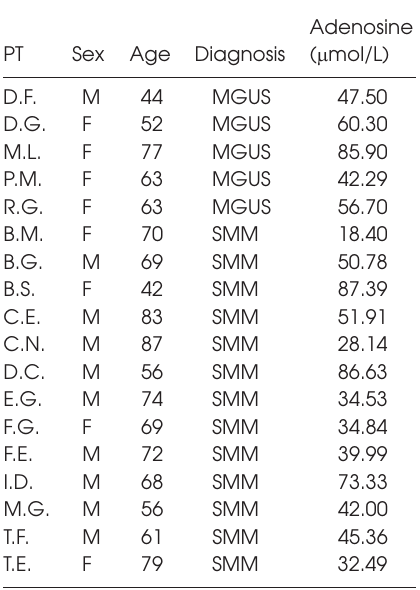
table 2. Characteristics of the cohort of 18 patients with asymptomatic (MGUS and SMM) dyscrasias.